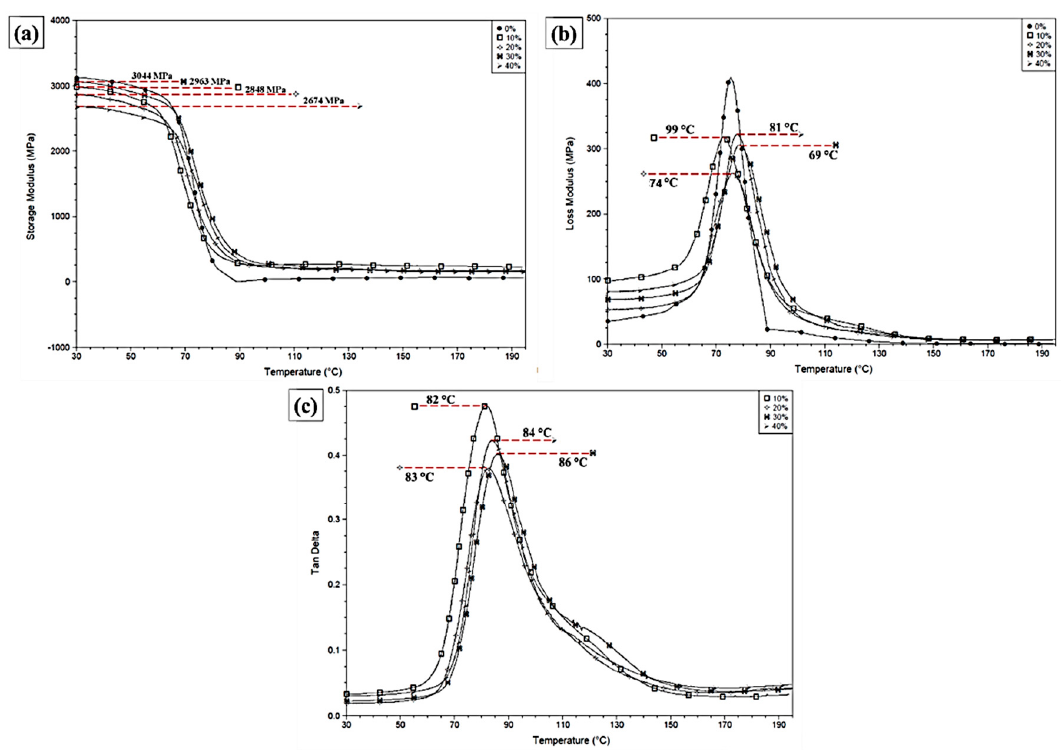
Figure 15. Dynamic mechanical analysis. ( a ) Storage modulus, ( b ) loss modulus, and ( c ) tangent delta for the carnauba fiber composites.